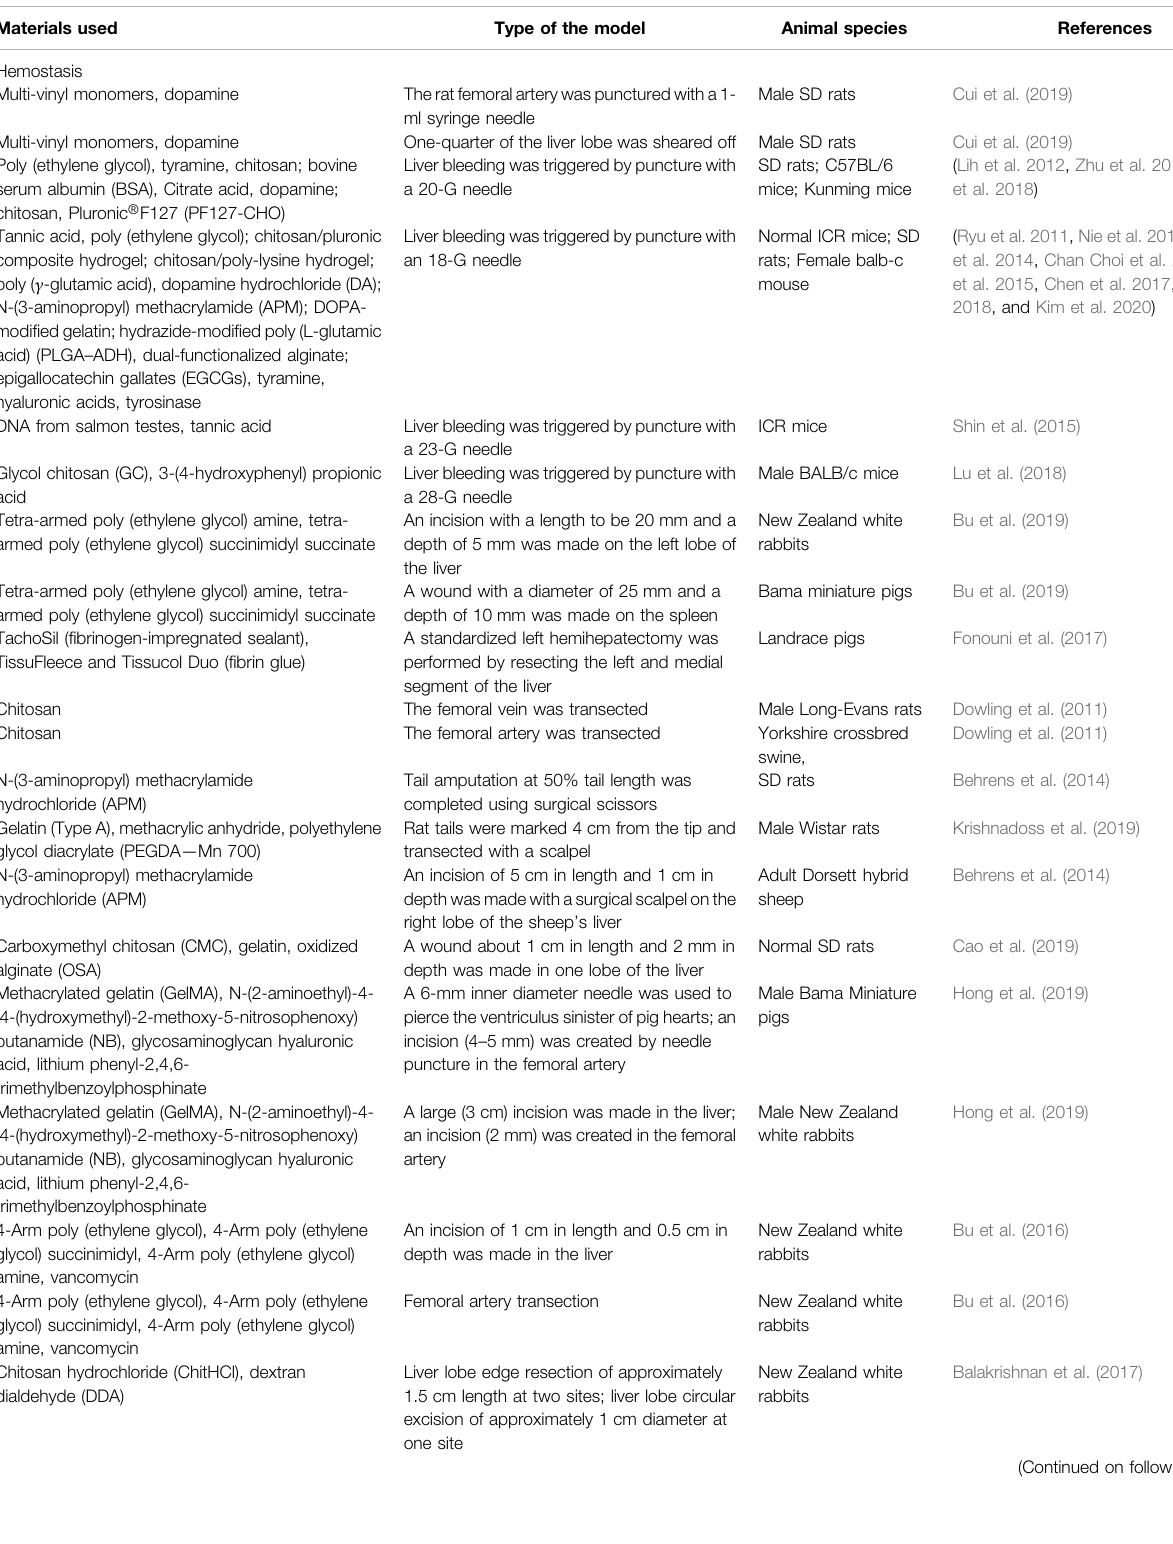
TABLE 2 | Bioadhesives for sealing